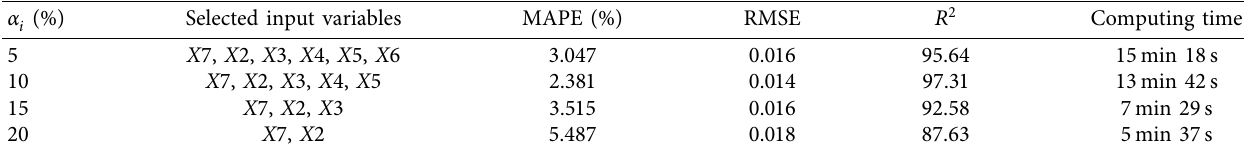
Table 11: Analysis of prediction results under different relative contribution rates.